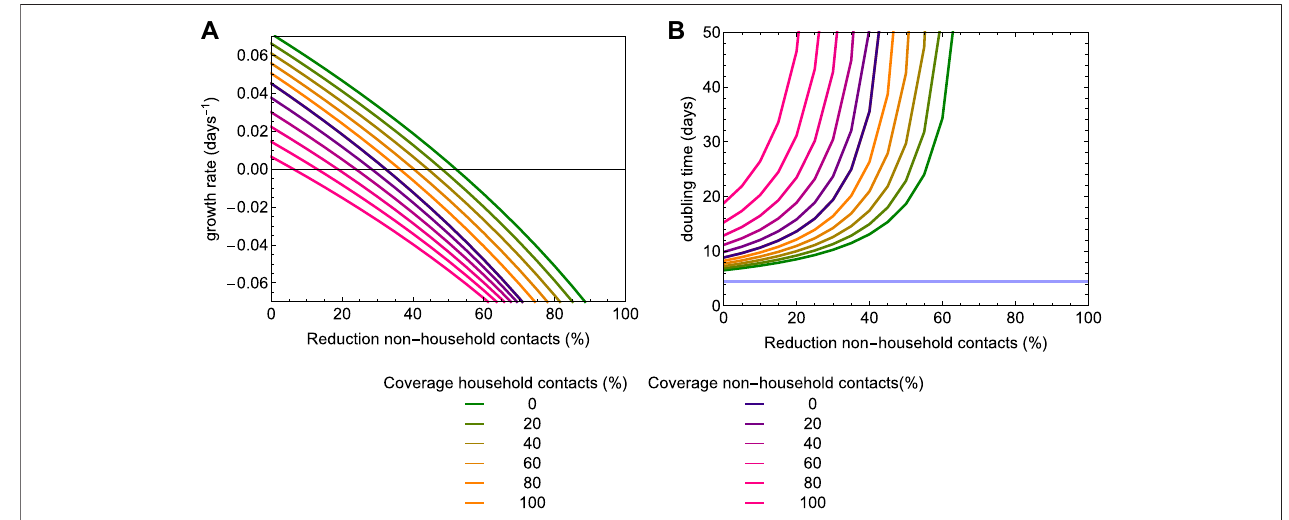
FIGURE 8 | The exponential growth rate (A) and epidemic doubling time (B) as a function of the level of social distancing and coverage of contact tracing. Testing coverage is set to 80%. The colors represent different coverage levels of contact tracing. For the lines colored from green to yellow only household contacts are traced and isolated; for the lines colored from blue to magenta, 100% of household contacts are traced and an additional fraction of non-household contacts are traced and isolated.